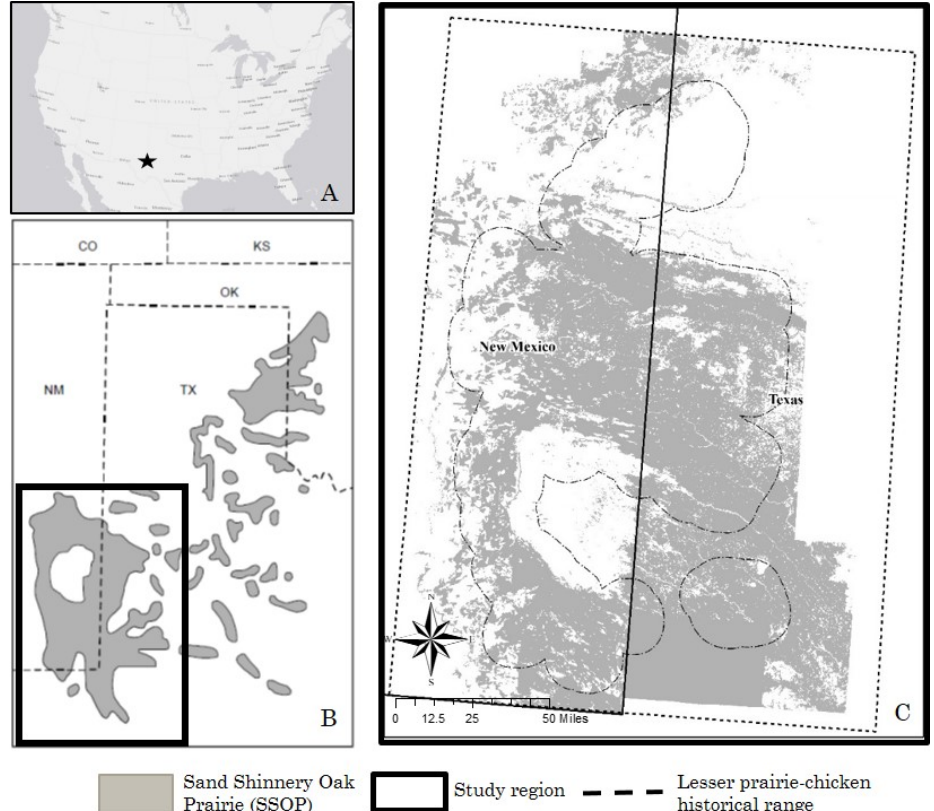
Figure 1. ( A ) Relative location of the study area in North America. ( B ) Distribution of sand shinnery oak prairies in New Mexico, Texas, and Oklahoma, reproduced from Peterson and Boyd (1998) [1]. The total potential distribution area of sand shinnery oak is estimated at ~4.1 million hectares. The highlighted polygon indicates the study area. ( C ) Overlay of the lesser prairie-chicken historical distribution range on the New Mexico and Texas Southern High Plains with the GIS layer for sandy soils distribution (grey color) from the US Department of Agriculture Soil Survey Geographic Database (USDA SSURGO) database.